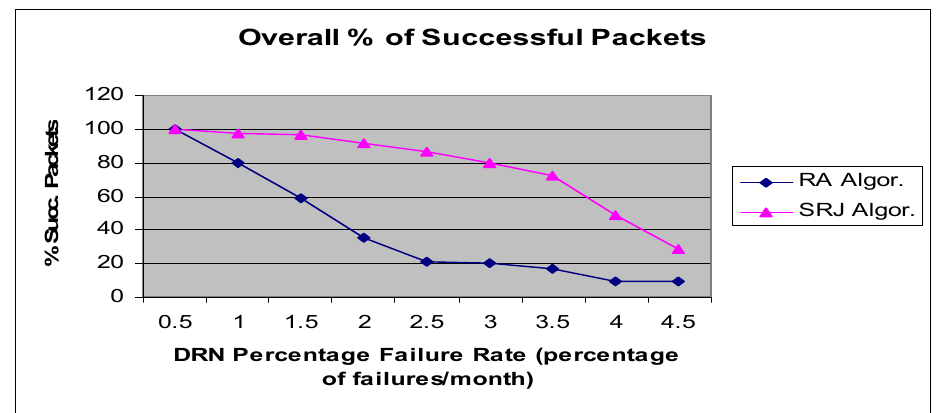
Figure 13. Simulation results for the hierarchical acoustic wireless sensor network. Percentage of successfully transmitted packets. NUM_DRN_PER_DDN = 100.